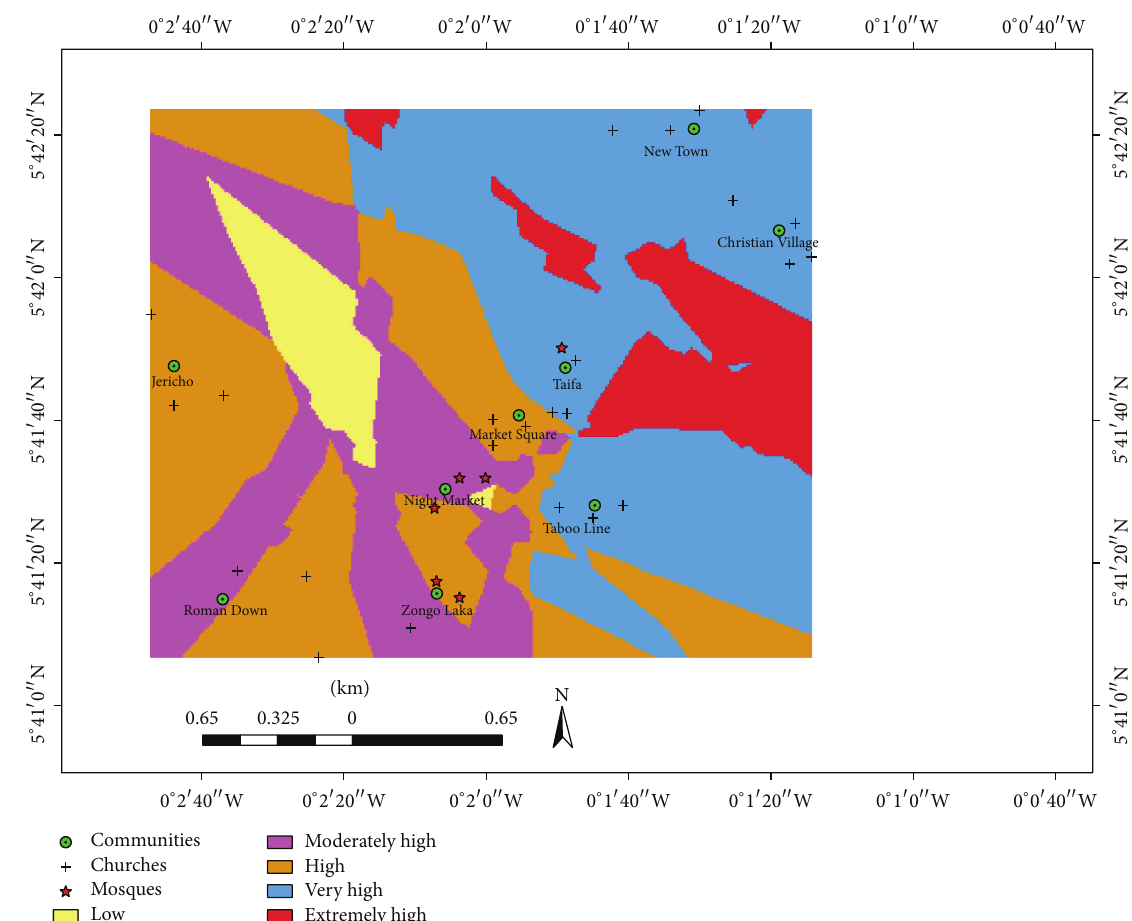
Figure 2: Noise map for in situ night-time noise levels in churches and